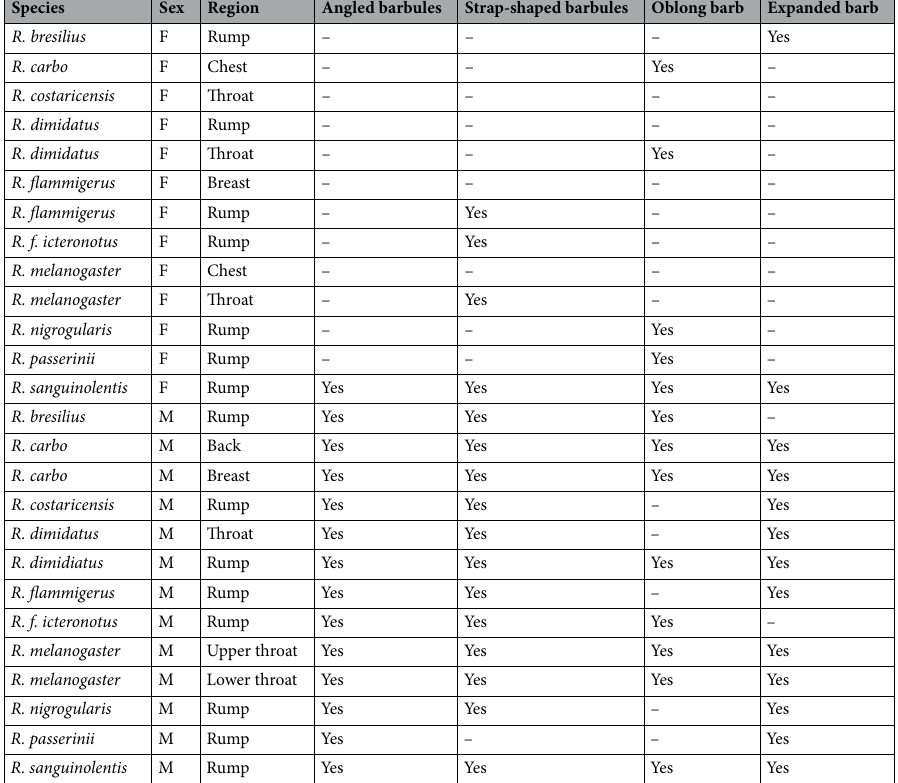
Table 1. Males, but not females, have diverse and elaborate feather microstructure. Male Ramphocelus tanagers have many atypical microstructural features compared to females. “3D barbules” refers to whether or not barbules extended upwards from the plane of the feather; “strap-shaped barbules” refers to whether barbules were flattened rather than classically cylindrical; “oblong barb” refers to whether barbs were taller than they were wide (numerical threshold: > median (max barb width)/(top-down barb width)); wide barb refers to whether the barb was expanded (numerical threshold: > median barb width value). Complete numerical measurements can be found in Table